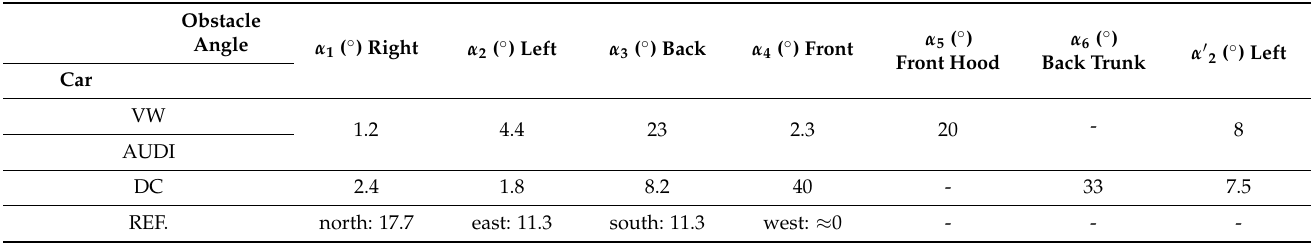
Table 2. View angle of obstacles seen from the right, left, back, front of the vehicle ( α i ) and parked along the vehicle ( α (cid:48) i ) (see Figure